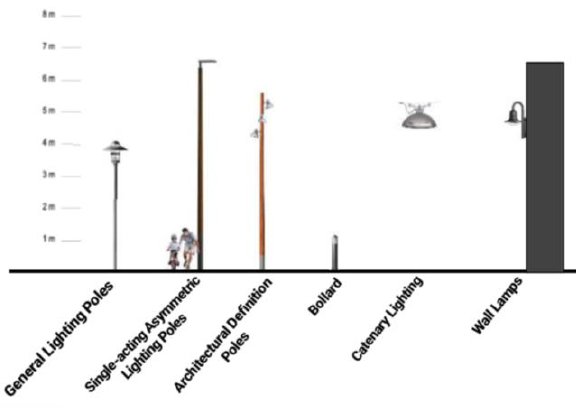
Figure 5. Possible lighting equipment types in the project